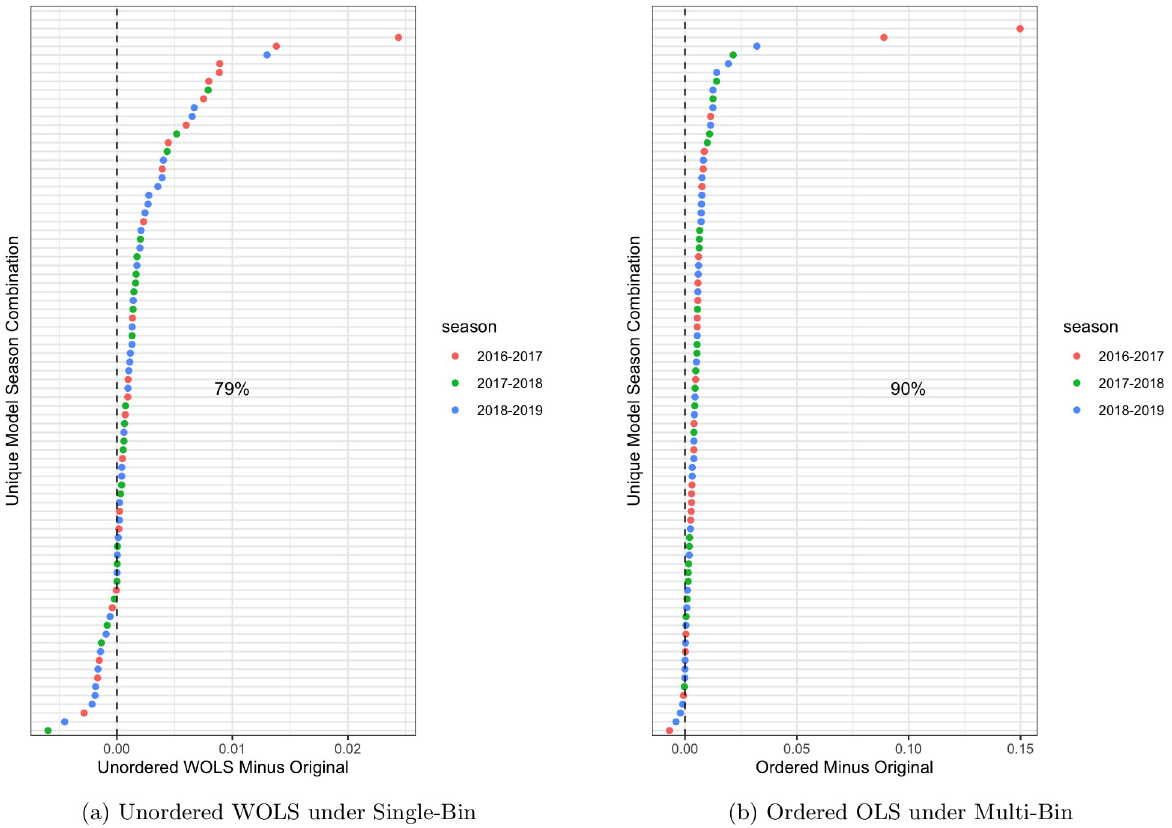
Fig 7. Best performing method under single-bin (left) and mutli-bin (right) in terms of forecast skill averaged over all targets (1-4 week ahead), regions (HHS1-10 & National) and broken down by model-season combination. The y-axis represents a unique season model combination which has been made anonymous to protect participant teams